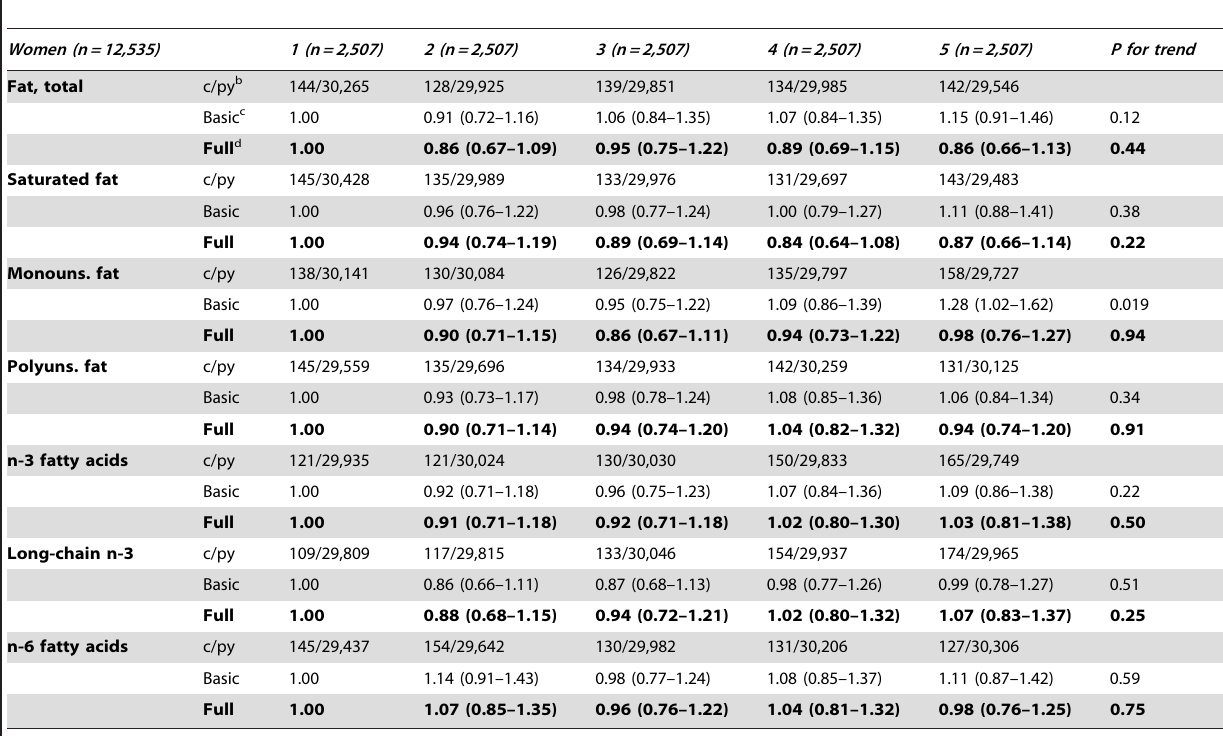
Table 4. Risk of total ischemic cardiovascular disease in 12,535 women (687 cases) a by intake of fat (multivariate hazard ratios with 95% confidence intervals per quintile of energy-adjusted intake).